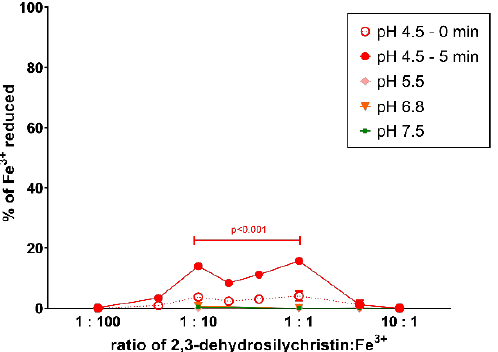
Figure 6. Ferric ion reduction potential of 2,3-dehydrosilychristin. Statistical comparison vs. the solvent (DMSO) is only shown for measurements performed at 5 min. No significant reduction was found at pH higher than 4.5.